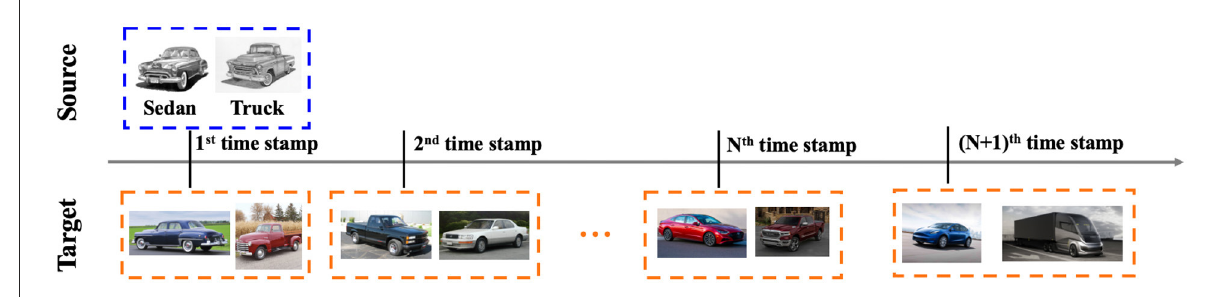
FIGURE1 Illustration of dynamic transfer learning from a static source task (e.g., sketch image classification with fully labeled examples) to a dynamic target task (e.g., real-world image classification with only unlabeled